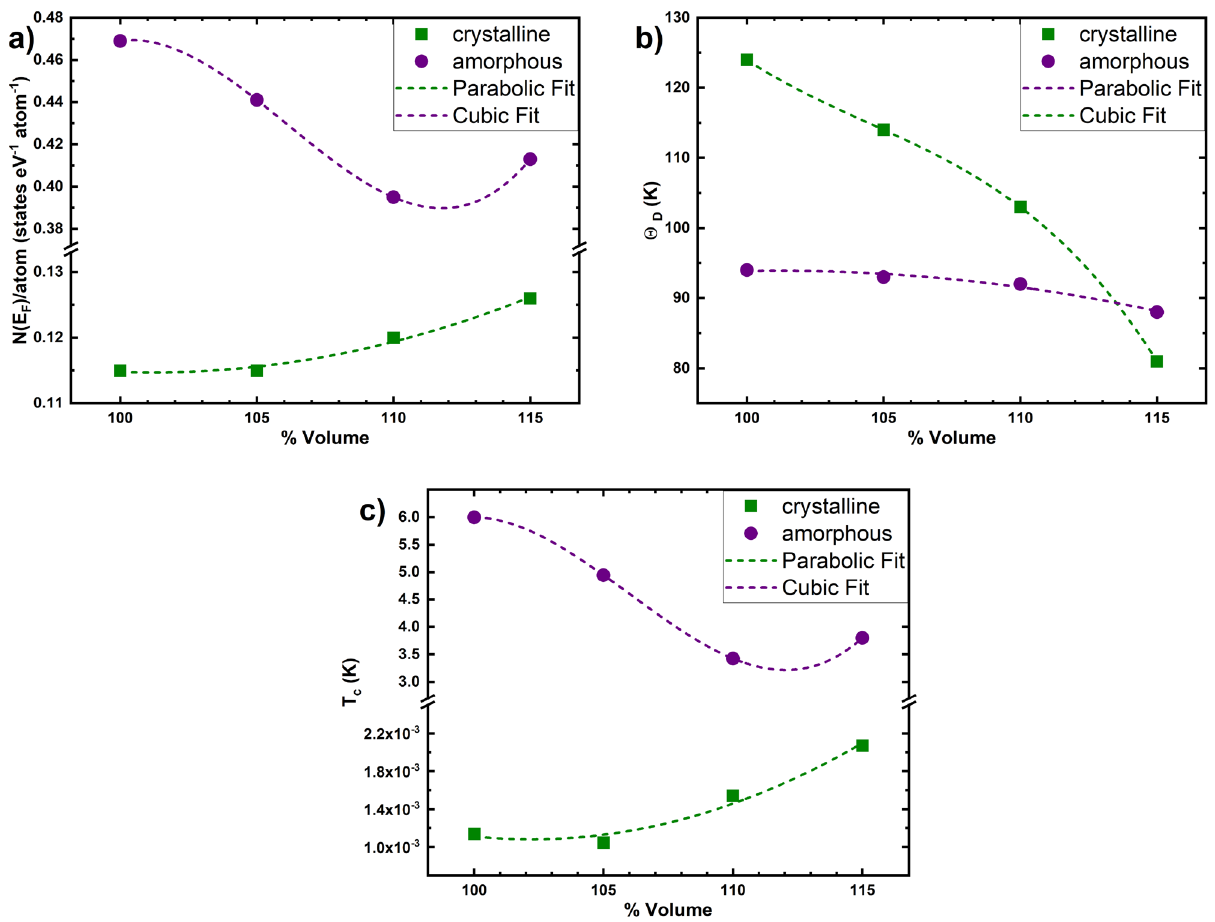
Figure 7. Graphical display of our results as a function of the expansion for crystalline and amorphous cells. Broken lines are parabolic and cubic fits for these results. ( a ) Electron densities of states (eDoS), ( b ) Debye temperatures ( θ D ), and ( c ) Superconducting transition temperatures ( T c ).